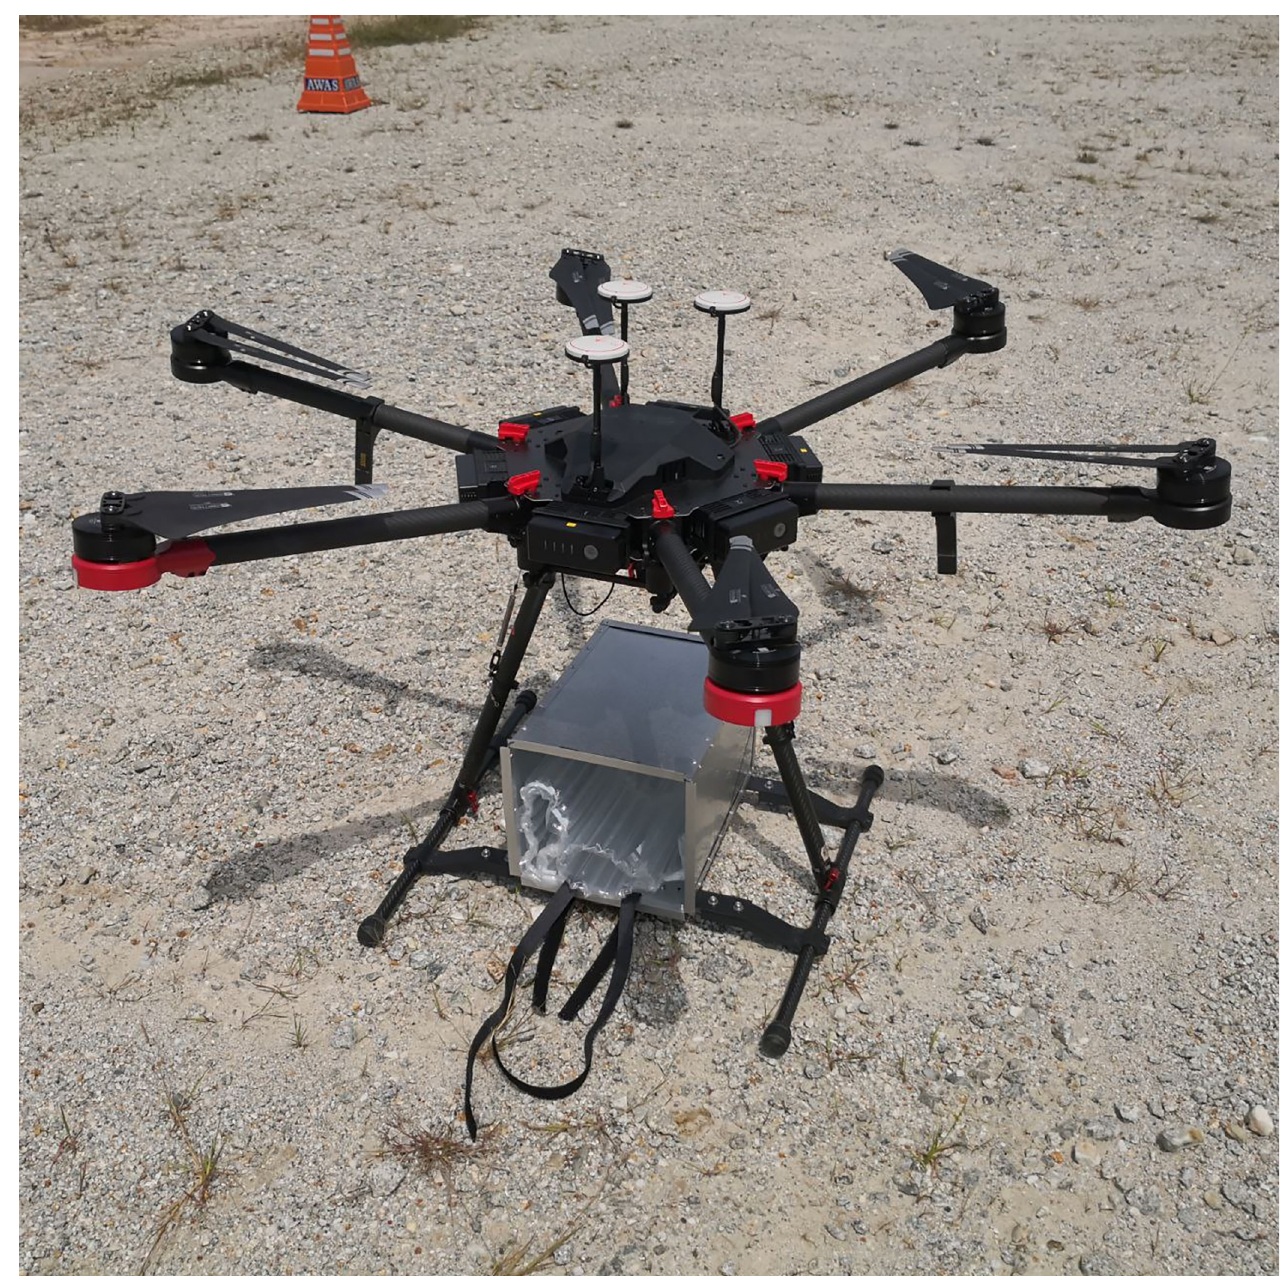
Fig 1. Multi-rotor drone. The multi-rotor drone that was used to transport our blood samples. https://doi.org/10.1371/journal.pone.0269866.g001 For Phase 1 flights (F1, F2 and F3), the carriage was filled with 2 units of simulated blood, ice packs, and a calibrated Fourtec MicroLite USB Datalogger LITE5032P-RH model (Fourtec Technologies Pte Ltd, Kuala Lumpur, Malaysia) with a total payload of 1.55 kg. For Phase 2 flights (F4 and F5), similar items were carried along with the blood samples in order to achieve the same total payload. We used simulated blood units consisting of distilled water that was dyed red (Star Brand Cochineal Red Artificial Food Colouring, Malaysia) instead of real blood